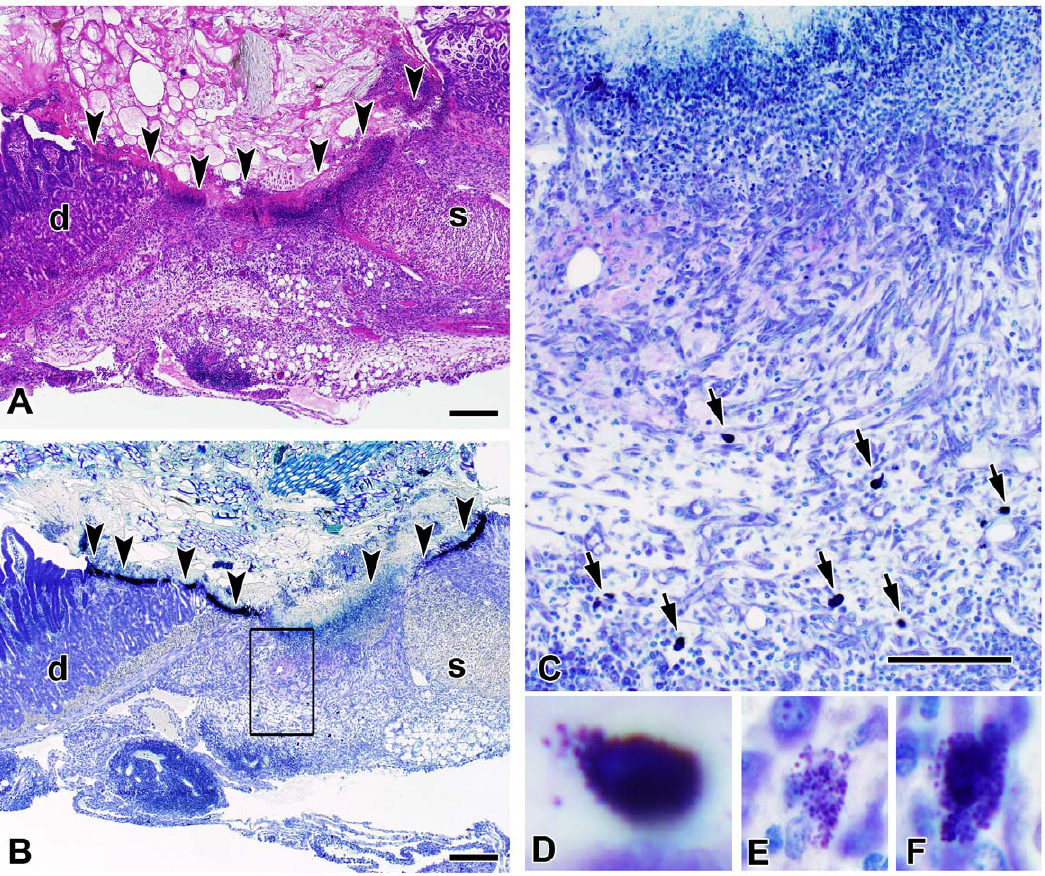
Figure 3. Mast cells in various stages of degranulation are present at the site of peptic ulceration. Hematoxylin and eosin- (panel A) and toluidine blue-stained sections (panels B–F) show a peptic ulcer located at the junction between the stomach (s) and duodenum (d). Arrowheads denote the extent of the ulcerated region. The intense purple staining adjacent to the arrowheads in panel B is derived from necrotic debris, inflammatory cells, and large numbers of metachromatic granules. Panel C shows the boxed region from panel B at higher magnification. Arrows point out mast cells in various stages of degranulation, as shown in panels D, E, F. Bar represents 200 m m in panels A and B and 100 m m in panel C.